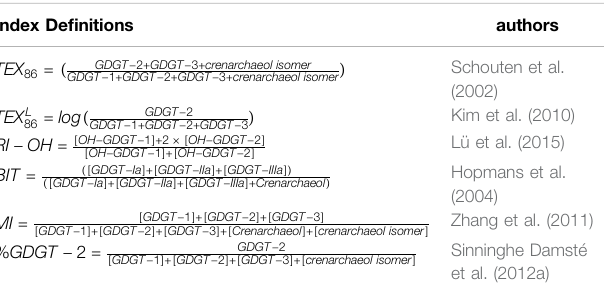
TABLE 1 | Initial de fi nitions of various proxies are used in this